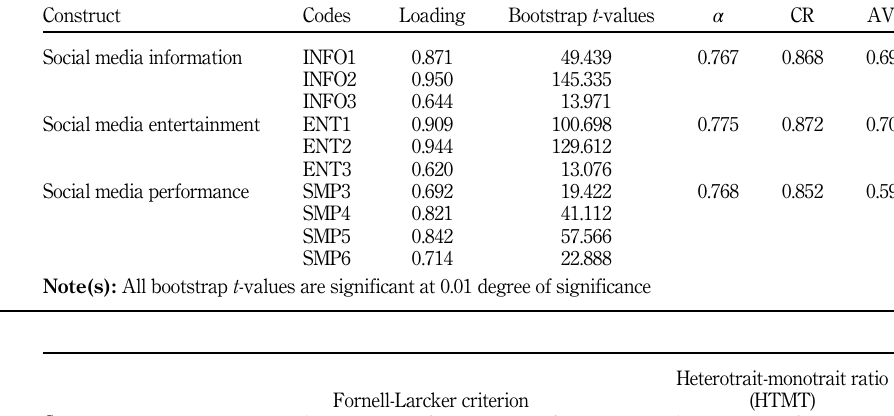
Table 4. Discriminant validity (squarerootofAVEsin